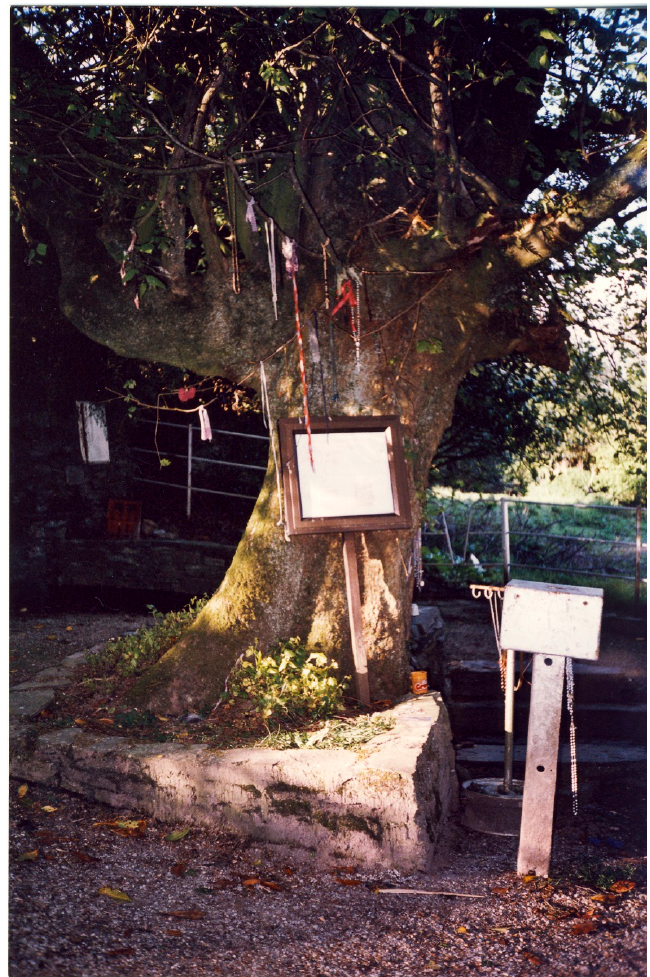
Figure 8. A tree with votive offerings at St. Gobnait’s Well in Ballyvourney. At the Chink Well near Portrane (Co. Dublin), the pilgrim was able to see what was the prospect of being cured, in this case specifically of whopping cough, by observing the piece of bread that was brought as a votive offering. If it was carried away by the tide of the sea, it was a good sign. Rags or ribbons are viewed as a scapegoat, riddances of “the spiritual or bodily ailments of the suppliant” (Wood-Martin 1895, p. 158). Leaving them should be accompanied by the ritual formula: “By the intercession of the Lord, I leave my portion of illness in this place” (Wood-Martin 1895, p. 158). Beside the rags are also ribbons, mostly white, red and blue. The red color was commonly used against evil spirits. Rosaries hanging next to the rags and ribbons are Christian additions. E. Estyn Evans (1942, p. 164) mentioned “strings of beads” tied to the holy tree, probably meaning rosaries. An interesting ritual was observed at the holy wells near Elphin and Castleragh (Co. Roscommon) in the nineteenth century. The pilgrims used to spit on the rags they hang in the trees. One of the oldest man said that “their an- cestors always did it”; it was to safeguard from “the sorceries of the druids: that their cattle were preserved by it, from infections and disorders”; also “the fairies were kept in good humour by it” (Logan [1980] 1992, p. 114) and did not harm the people. As Logan noticed: “Spittle is regarded as something very personal, and renders the object very